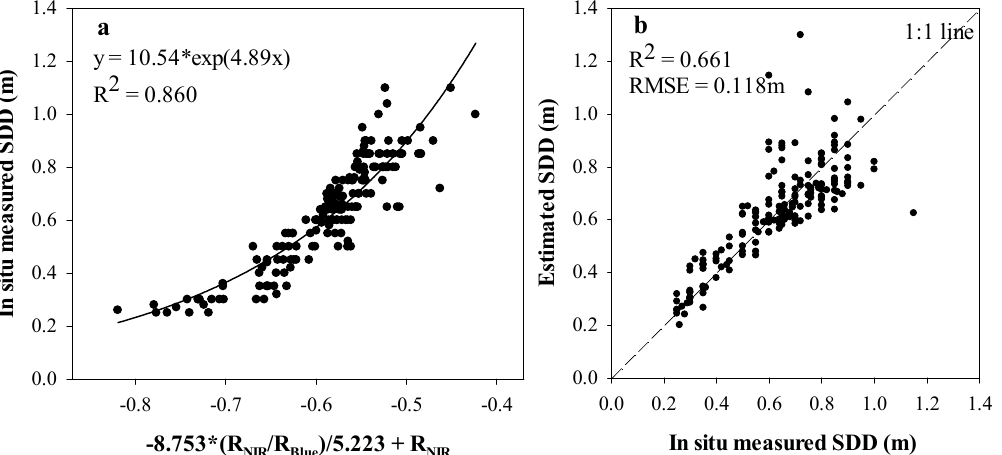
Figure 2. The SDD algorithms for ( a ) the calibration of in situ measured SDDs and Landsat reflectance and ( b ) the validation of Landsat-estimated SDDs with in situ measured SDD. R Blue and R NIR represent the atmospherically corrected reflectance values of the blue band and near-infrared band in the Landsat images, respectively.